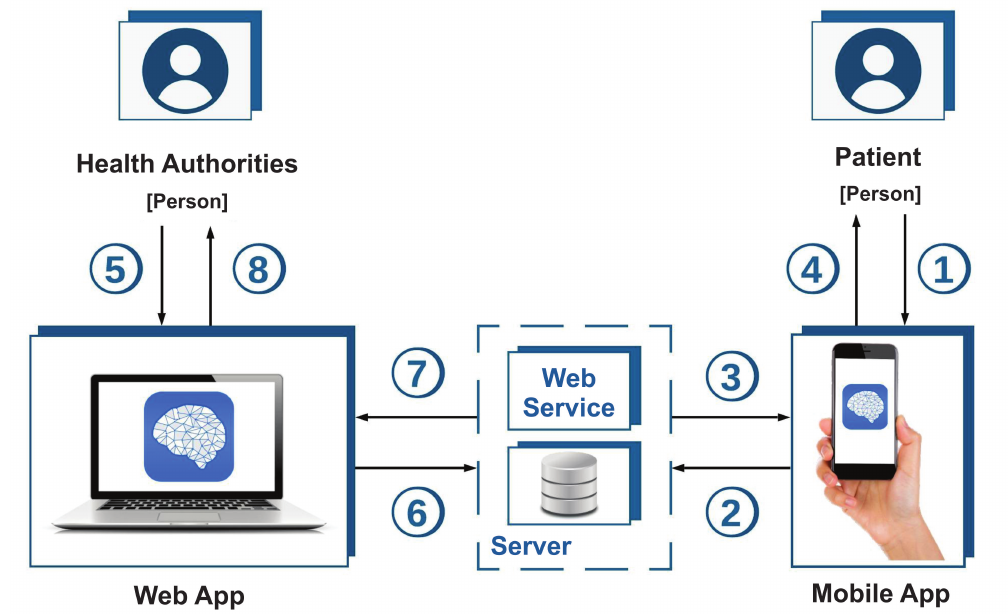
Figure 1. Platform diagram. The mobile application and the web application interact via a web service and a database to create a single platform. When using the mobile application, the student can complete the auxiliary inventories for the diagnosis of anxiety and depression, as well as recording their mood throughout the day. The mobile app stores the information in a database, using the web service. When required, the mobile app extracts information from the student’s mood logs from the database, so that the student can visualize graphs and diagrams with information about their mood logs. A specialist/administrator can also generate reports based on the results of the inventories and mood of students via the web application, which transfers information from the inventories and state of mind records to the database. The information is extracted from the database according to the criteria indicated by the specialist, who, in addition, can, by using the web application, visualize information derived from the inventories and the mood of the students as a basis for